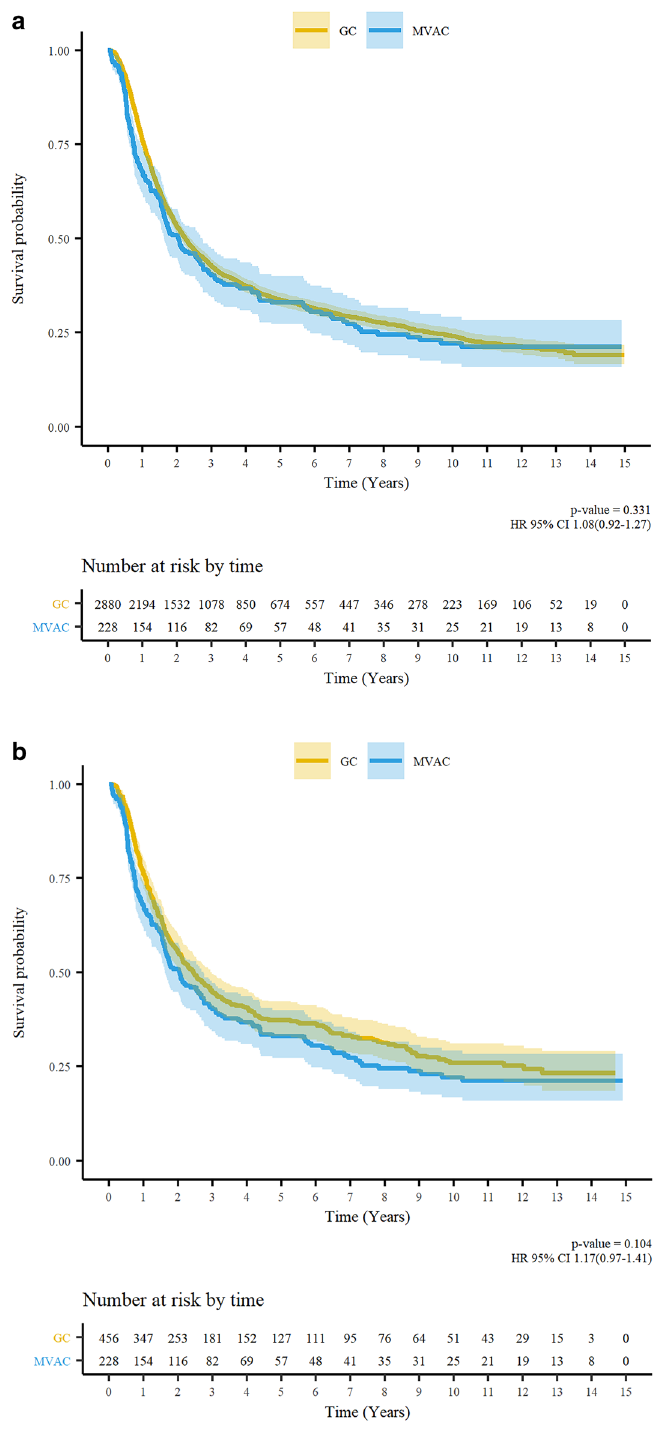
Figure 3. Kaplan–Meier survival curves and log-rank tests for overall survival ( A ) before propensity score matching and ( B ) after propensity score matching. AC, adjuvant chemotherapy; NAC, neoadjuvant chemotherapy; HR, hazard ratio; CI, confidence